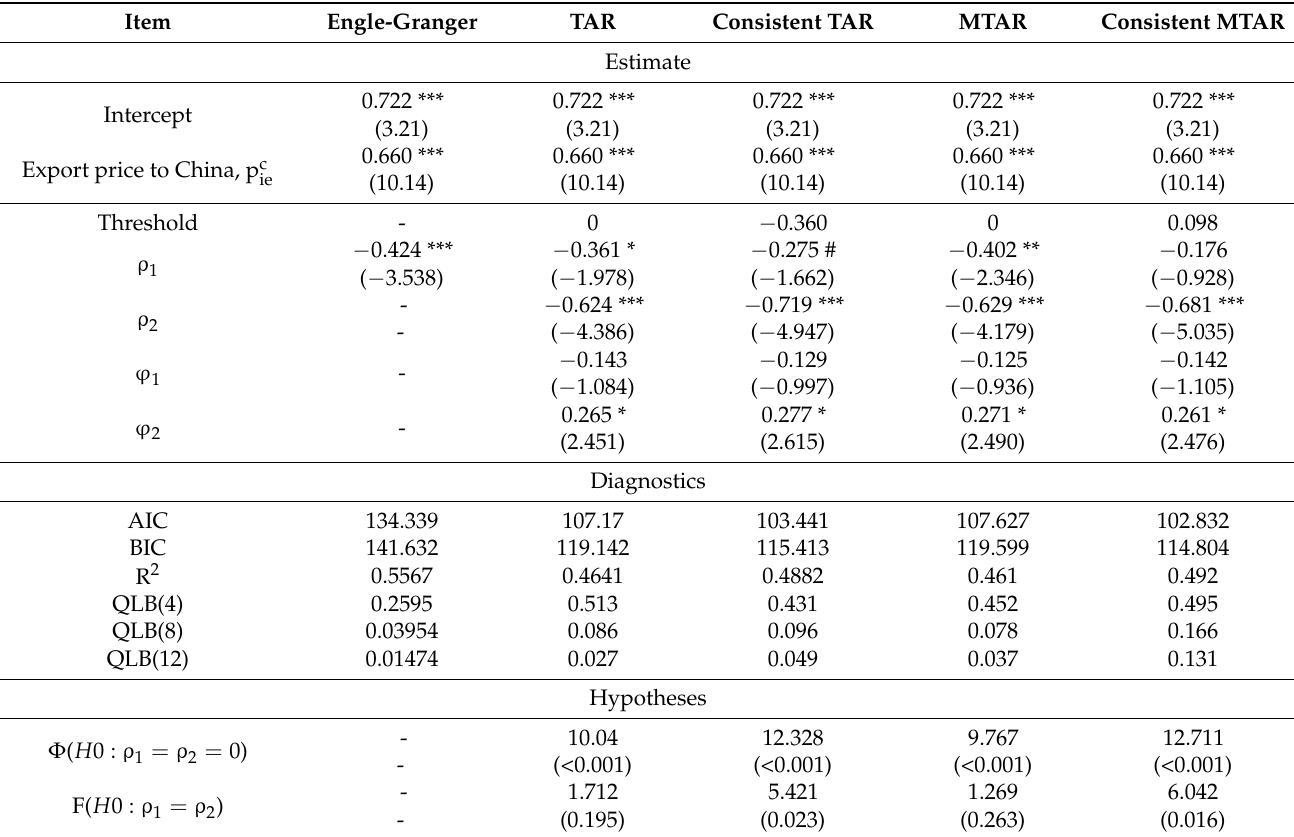
Table 3. Engle-Granger and threshold cointegration tests results for Irish SMP export